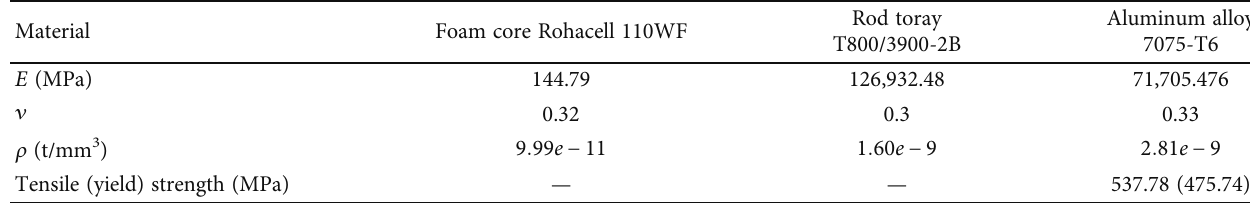
Table 2: Material properties of noncomposite components [6].